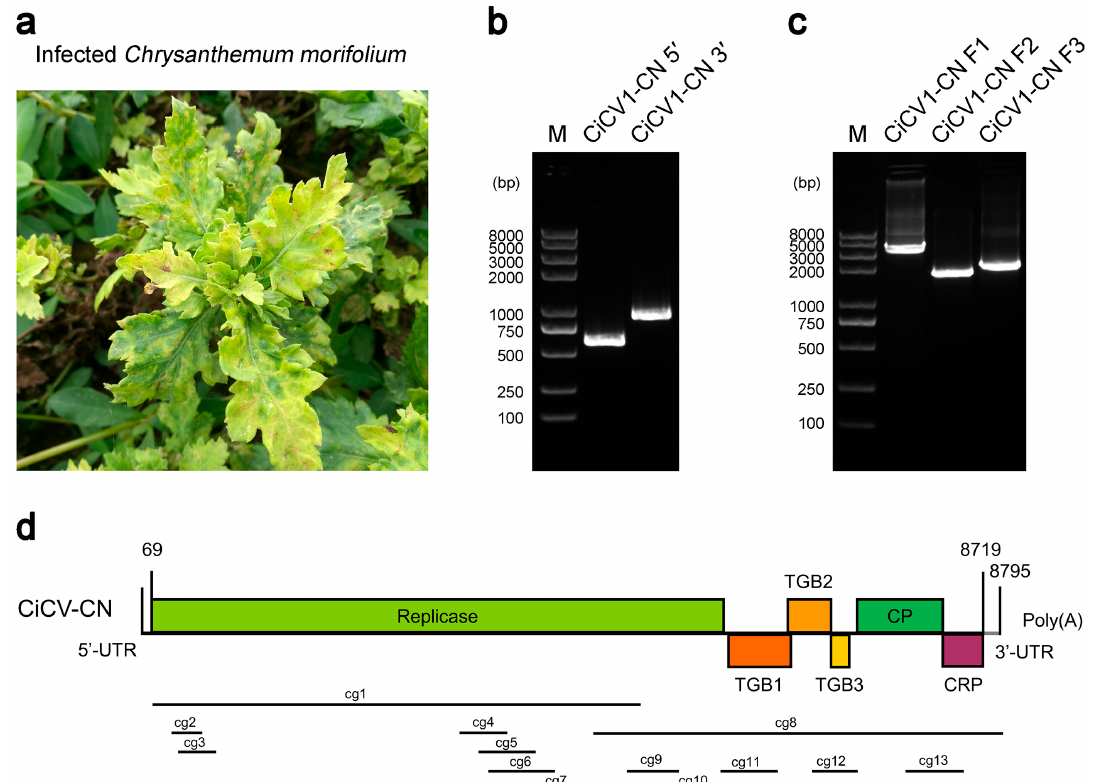
Figure 1. Symptoms, molecular cloning, and genome structure of the Chinese isolate of Carya illinoinensis carlavirus 1 (CiCV1-CN) from Chrysanthemum morifolium . ( a ) Symptoms of CiCV1-CN in C. morifolium . ( b ) 5 ′ - and 3 ′ -RACE (rapid amplification of cDNA ends) cloning of CiCV1-CN. M: DNA marker. ( c ) Reverse transcription PCR (RT-PCR) cloning of internal genomic fragments (F1, F2, and F3) of CiCV1-CN. M: DNA marker. ( d ) Genomic organization of CiCV1-CN. The predicted open reading frames (ORFs) are marked with different rectangles, and 13 contigs assembled from virus-derived small RNAs are indicated with black lines.